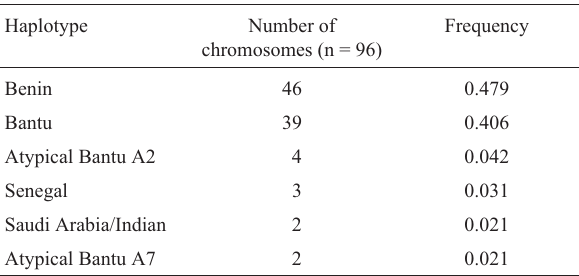
Table I - β -globin gene cluster haplotypes identified in a sample of 96 chromosomes from Venezuelan sickle cell patients